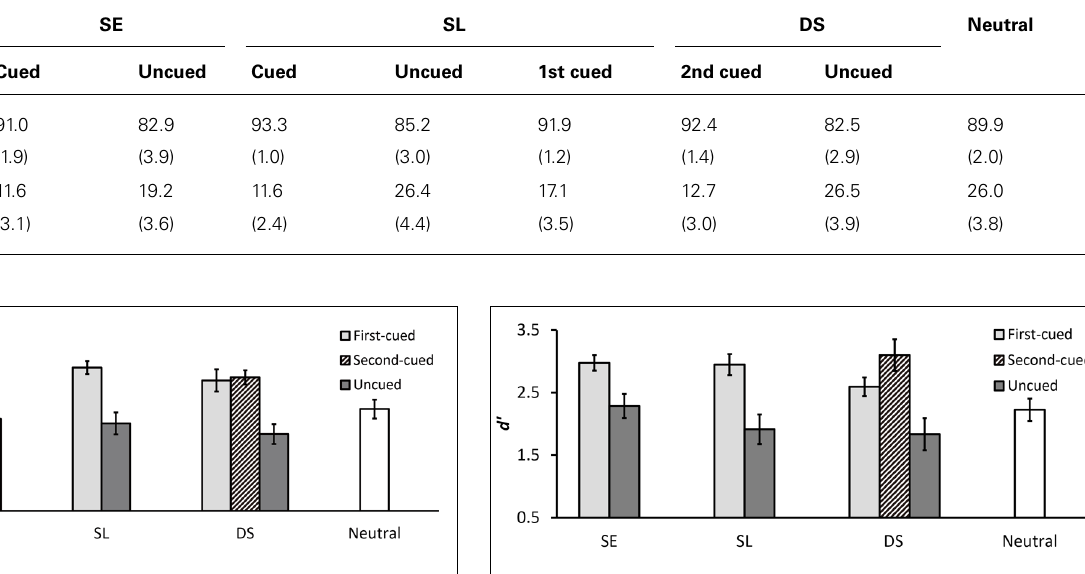
FIGURE 5 | Mean d (cid:2) for each cue type condition in Experiment 2. Error bars represent standard errors.